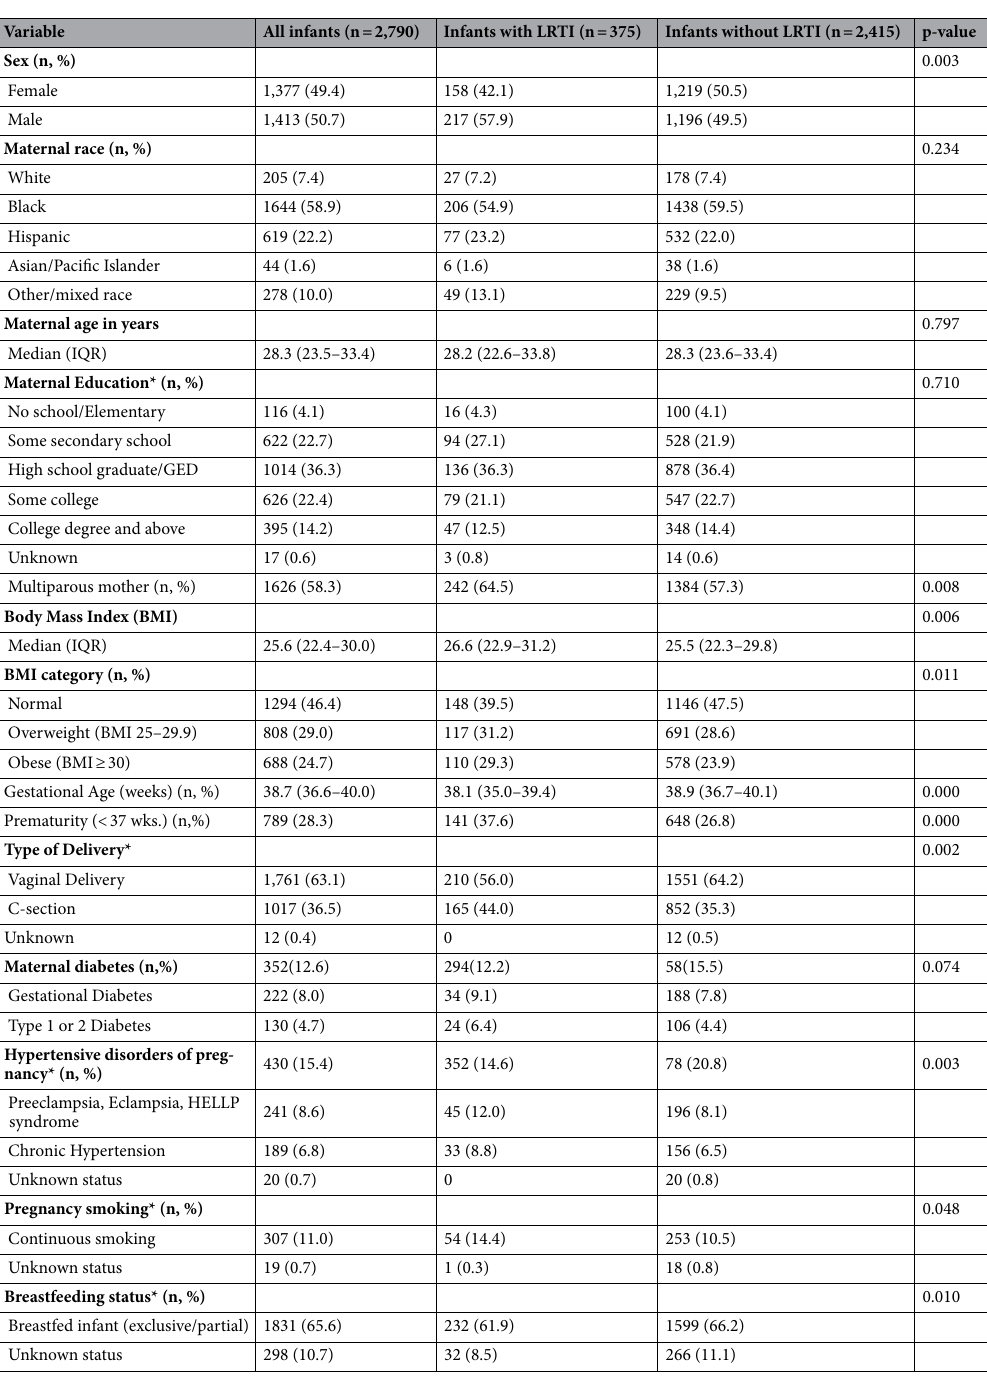
Table 1. Demographic and clinical characteristics. Infants with LRTI were defined as those who developed bronchiolitis, bronchitis, or pneumonia during the first year of life as defined by ICD9 or ICD10 diagnosis in the Boston Birth Cohort (BBC) database. Maternal age, body mass index (BMI), and infant gestational age (GA) at birth are displayed as median and IQR (interquartile range) as their distributions were not Gaussian. There were significant differences in sex, parity, number of preterm infants, type of delivery, maternal smoking, and breastfeeding status between the two groups. There were also significant differences in maternal BMI and infant gestational age at birth between the group of infants who developed LRTI during the first year of life compared with those that did not. There were none or minimal amounts of missing data (< 1%) in most covariates, except for breastfeeding status that was unknown in ~ 11% of children. IQR = Interquartile range, GED = Graduate Equivalence Degree, HELLP = hemolysis, elevated liver enzymes, low platelet count. * Variables with missing